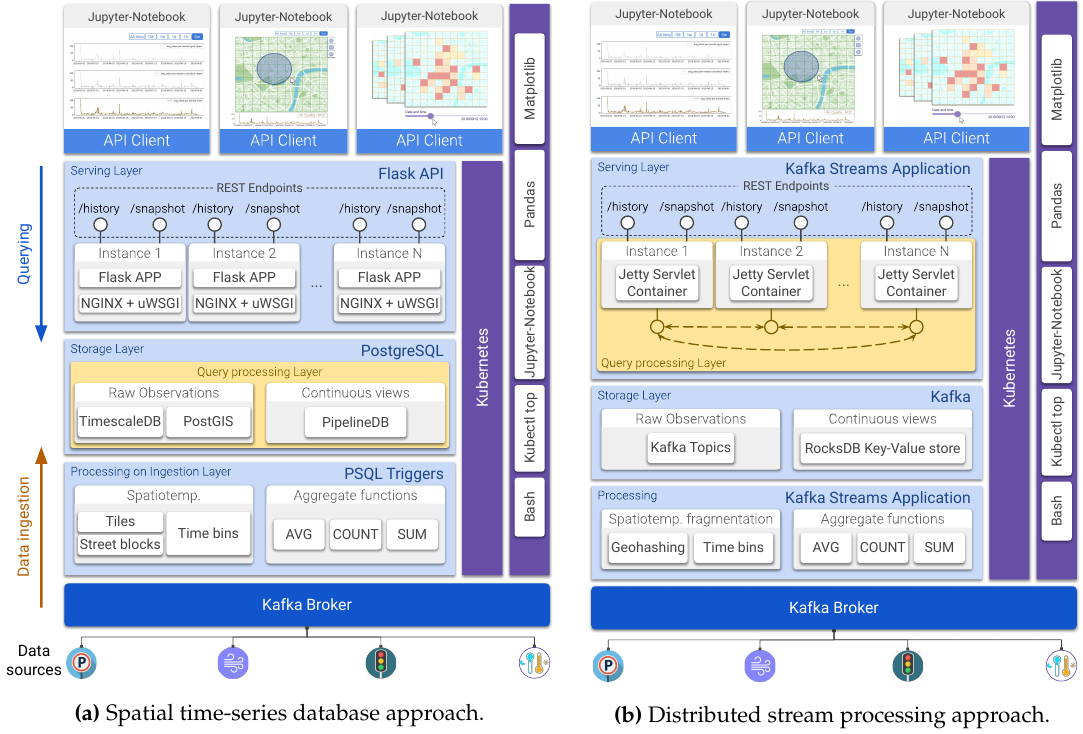
Figure 10. Proof-of-concept implementations of E XPLORA